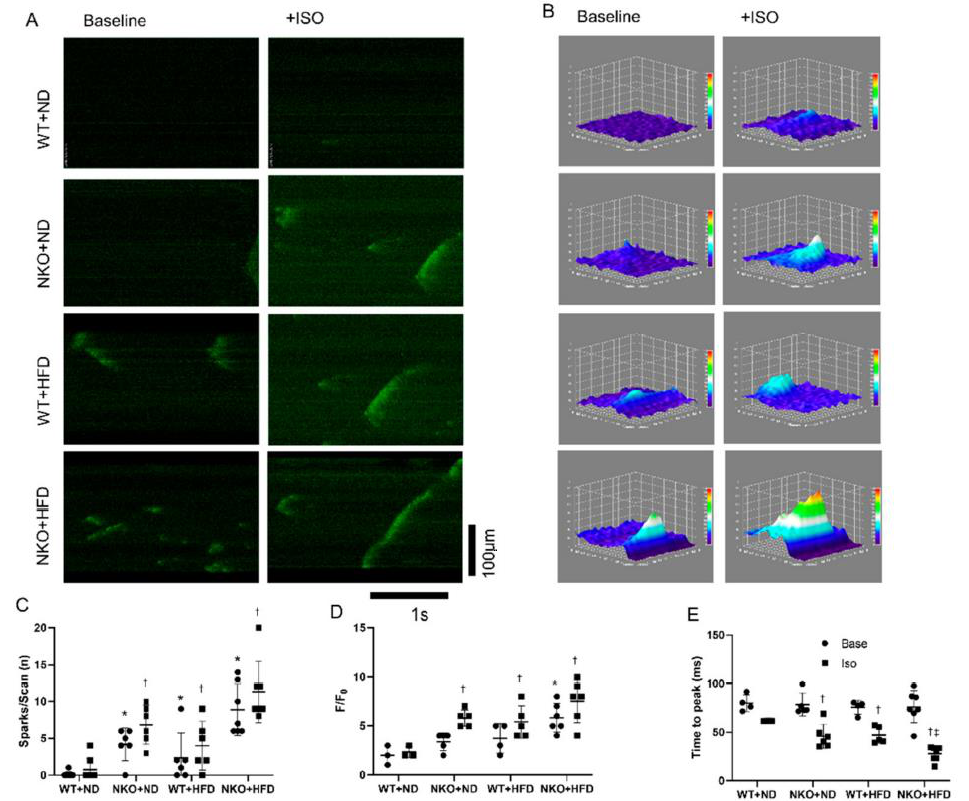
mRNA expression levels in the atrial tissues evaluated by quantitative PCR ( n = 4 mice per group). ( D ) Representative Western Blots for Nampt and Sirt1 in the atrial tissues ( n = 3 mice per group). ( E ) Nampt protein expression levels in the atrial tissues ( n = 3 mice per group). ( F ) Sirt1 protein expression levels in the atrial tissues ( n = 3 mice per group). ( G ) Representative images of Nampt immunohistochemistry in the atrial tissues. Nampt was mainly expressed in the cytoplasm of atrial cardiomyocytes. Scale bar: 50 µ m. ( H ) Positively stained areas in the atrial tissues by immunohis- tochemistry. ( I ) Atrial NAD/NADH ratio in four studied groups ( n = 4 mice per group). * p < 0.05 vs. WT+ND mice. Data are shown as mean ± SD. Statistical comparisons between multiple groups: Int. J. Mol. Sci. 2020 , 21 , x FOR PEER REVIEW one-way ANOVA followed by a post hoc Bonferroni test.